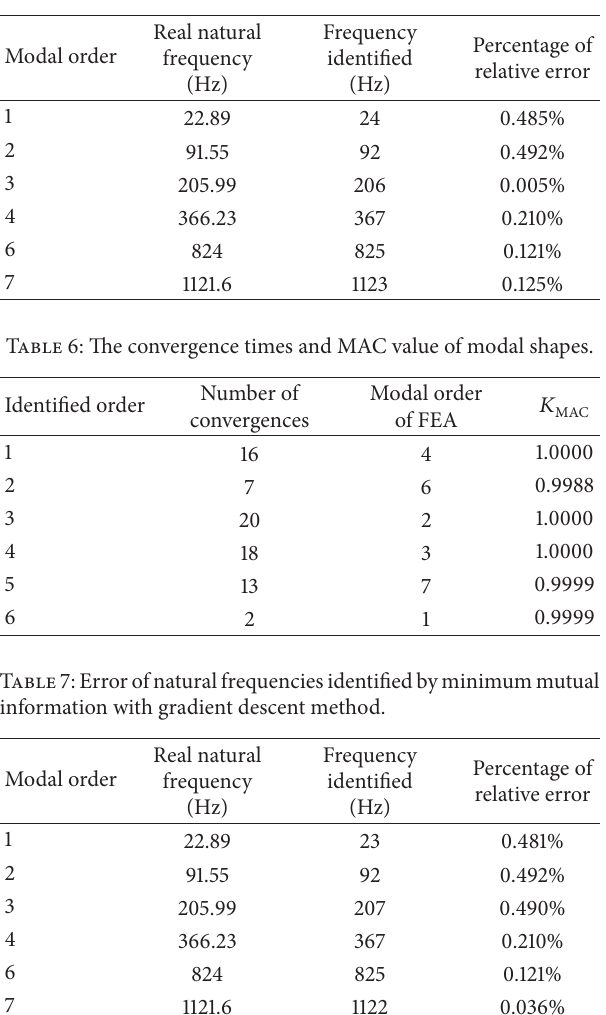
Table 3: Error of natural frequencies identified by maximization kurtosis with gradient descent method.